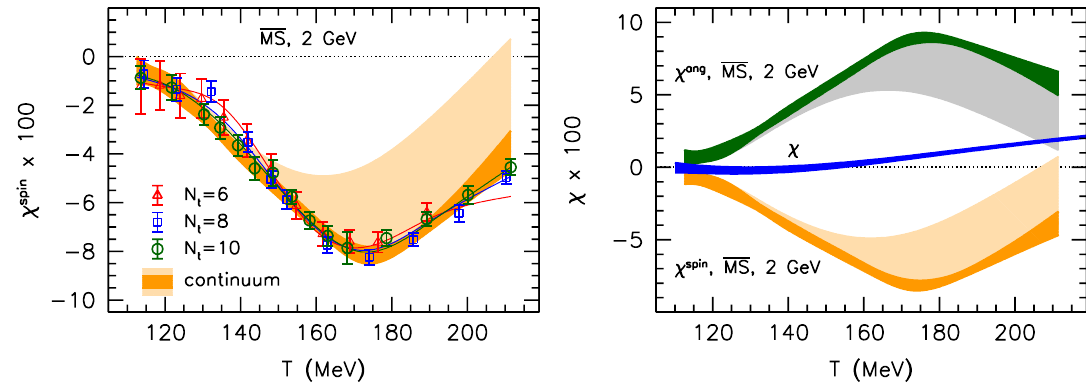
Figure 9 . Left panel: spin contribution to the susceptibility using three lattice spacings (colored symbols) and an extrapolation to the continuum limit (orange band). A systematic uncertainty, related to the estimation of the tensor coe(cid:14)cient for massless valence quarks, is indicated by the light yellow band. Right panel: the total magnetic susceptibility from (cid:12)gure 4 (blue), together with the decomposition into spin (orange-yellow) and orbital angular momentum (green-gray)